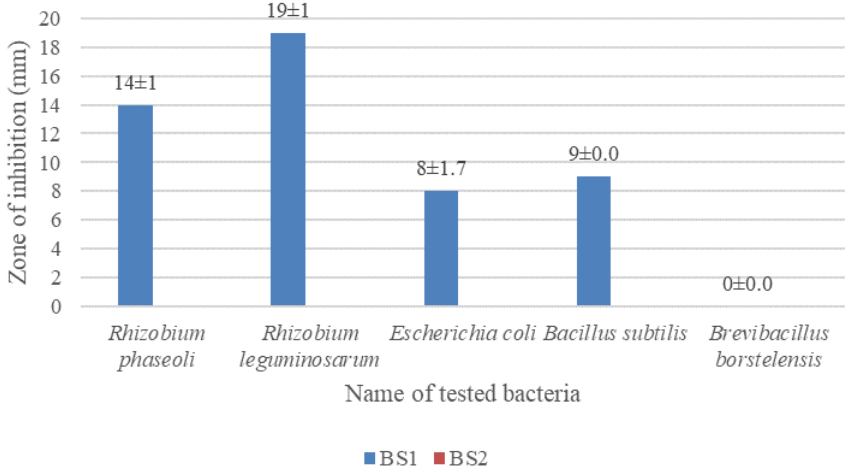
Figure 5. Antagonistic activity of soil bacteria, Rhizobium phaseoli, Rhizobium leguminosarum, Escherichia coli, Bacillus subtilis and Brevibacillus borstelensis against the isolates BS1 and BS2 (it was done in Figure 4). Isolates were grown on LB agar; test bacteria were cultured and incubated at 37°C for 18 hours.